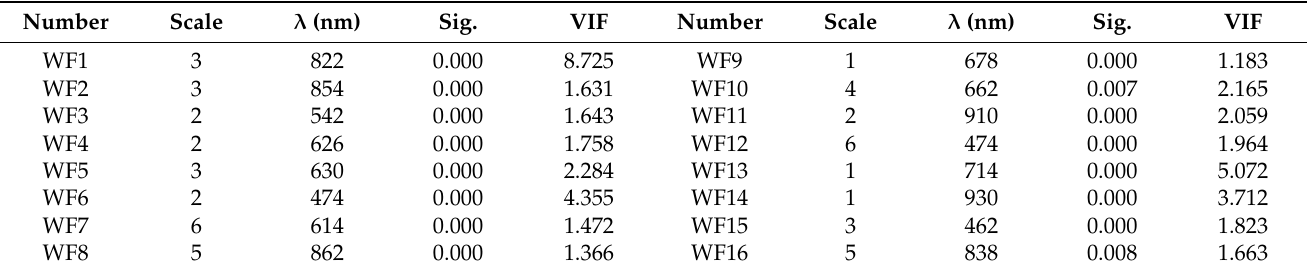
Table 6. CWT characteristics and collinearity statistics.